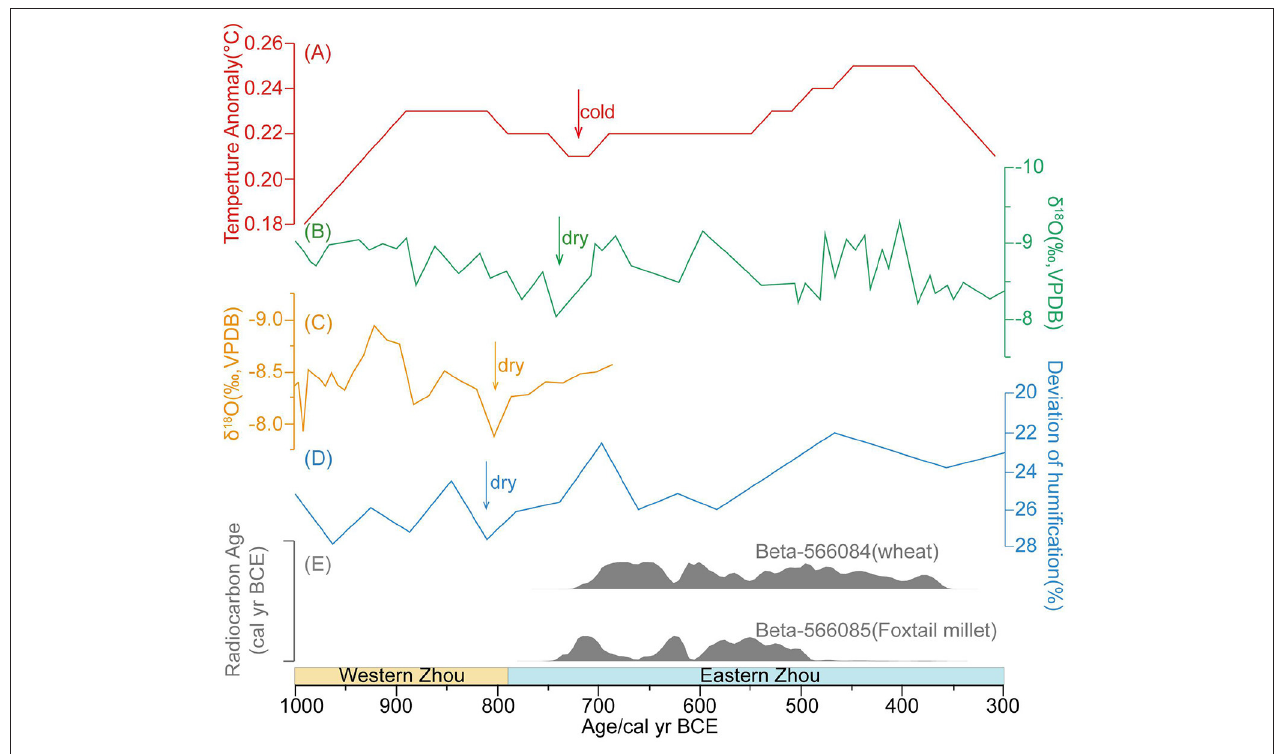
FIGURE 4 | The comparison between climate records and human land use in the coastal area of Jiangsu Province around 2.8 ka BP. (A) Temperature anomaly in the Northern Hemisphere (Marcott et al., 2013); (B) δ 18 O records from Heshang Cave (Hu et al., 2007); (C) δ 18 O records from Wuya Cave (Tan et al., 2020b); (D) Record in peat humification in Tianmu mountain Region ( Ma et al., 2008); (E) Age of Datongpu site (this